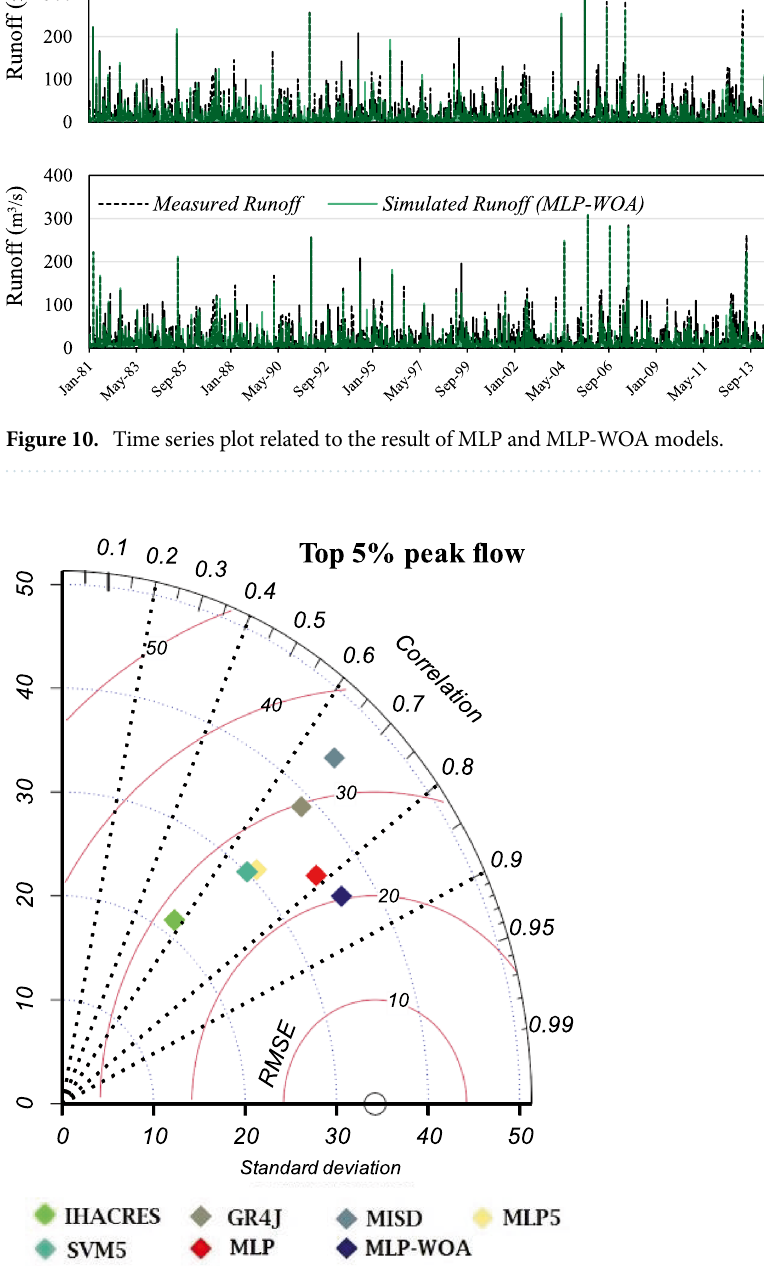
Figure 11. Taylor diagram of top 5% peak flow during the study period